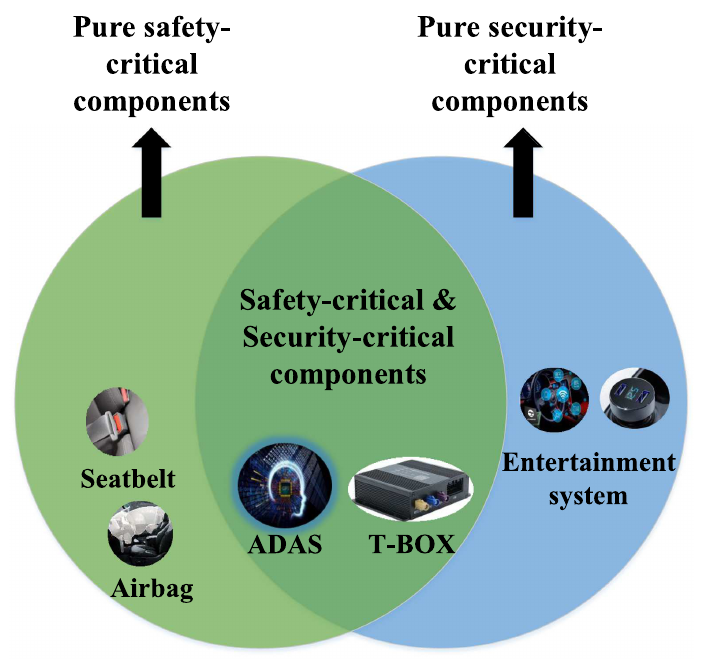
Figure 3. Safety/security attributes of in-vehicle